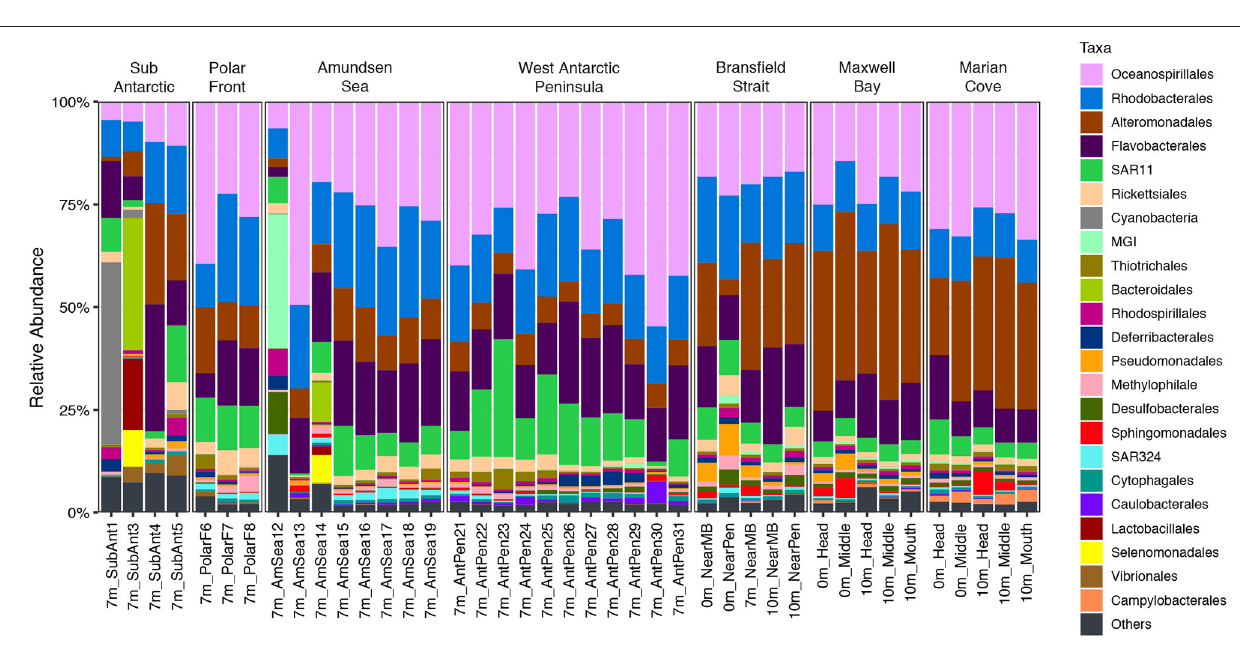
the second zone that presented a high number of indicators OTUs (281 OTUs). Furthermore, OTUs from the order Campylobacterales were selected as exclusive indicator OTUs for this zone ( Figure 7 and Supplementary Table 6